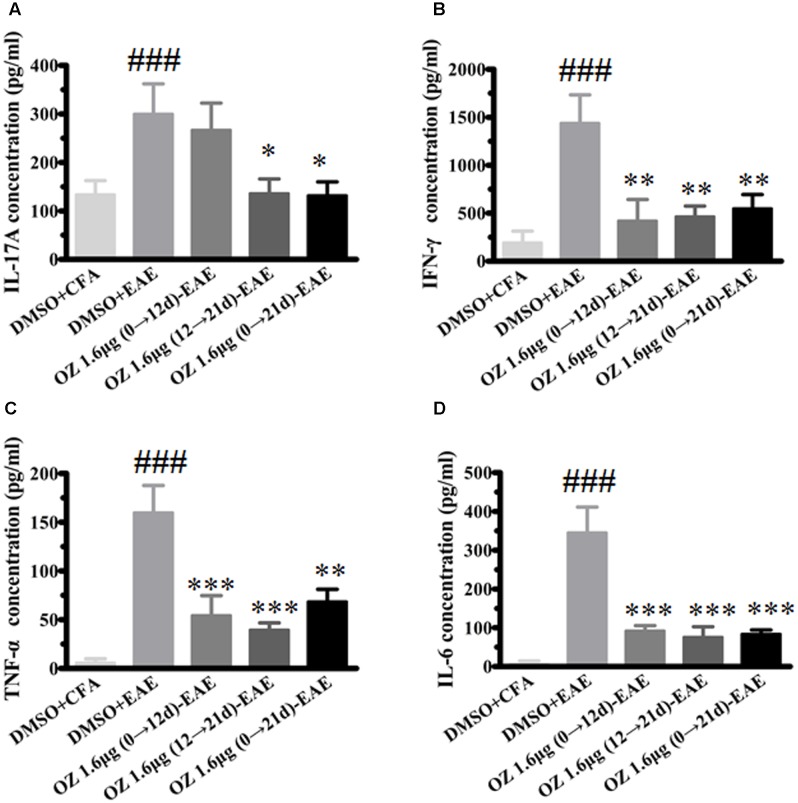
The effects of 5Z-7-oxozeaenol treatment on pro-inflammatory cytokines produced by splenocytes in the EAE model. Splenocytes were harvested and stimulated with 20 μg MOG35-55 for 48 h. The supernatants were harvested and analyzed for cytokine content by ELISA. (A) Quantification of IL-17A levels. (B) Quantification of IFN-γ levels. (C) Quantification of TNF-α levels. (D) Quantification of IL-6 levels. The data are expressed as mean ± SEM (n = 4 mice per group). ∗P < 0.05, ∗∗P < 0.01, ∗∗∗P < 0.001 versus DMSO-EAE group, ###P < 0.001 versus DMSO-CFA group (one-way ANOVA). OZ, 5Z-7-oxozeaenol.